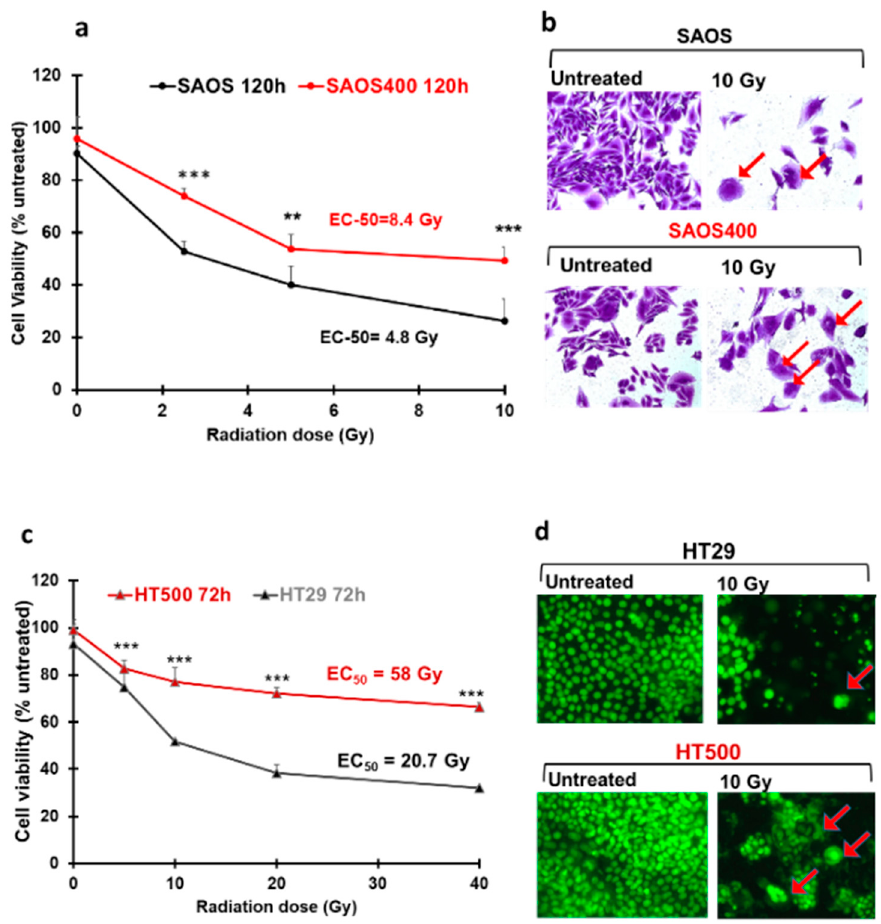
Figure 2. Radio-resistance of SAOS400 and HT500 cells compared to their parental cell lines. Changes in cell viability after increasing doses of γ -rays in SAOS vs. SAOS400 (panel a ) and HT29 vs. HT500 cells (panel c ). Data represent the mean of three independent experiments ( ± SD). Symbols indicate significance: ** p < 0.01 or *** p < 0.001 of the parental cells compared to the radio-resistant sub-population (Student’s t-test). The calculated EC50s are reported as inserts within the graphs. Photographs (400x magnification) show representative fields of untreated and SAOS or SAOS400 cells after IR (10 Gy), stained with Crystal Violet dye (panel b ) or untreated and IR-treated (10 Gy) HT29 or HT500 cells stained with CyQuant dye (panel d